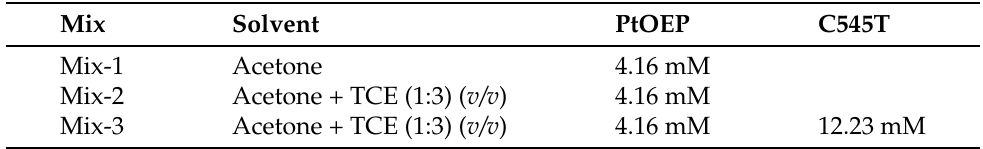
Table 1. Mixtures used for sensor